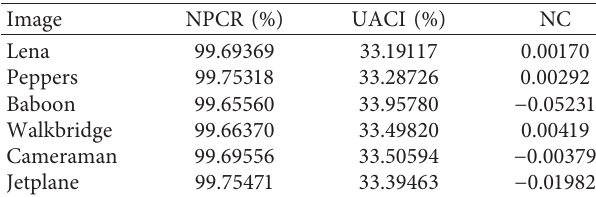
Figure 5: Key sensitivity test applied on the initial key: (a) encrypted Lena by key K (a) and (b), (d) decrypted (a) by key K i Table 7: NC, NPCR, and UACI tests applied on the initial